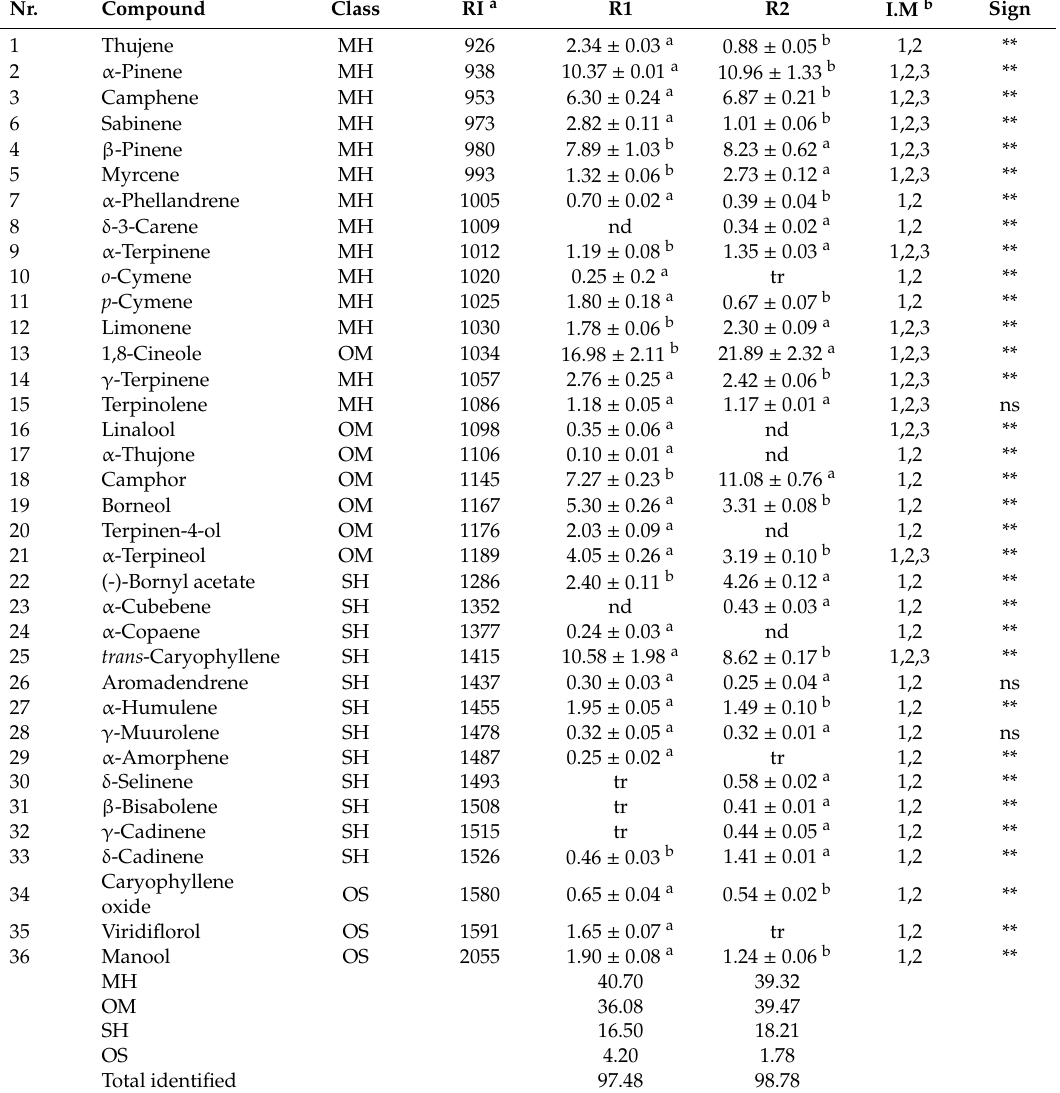
Table 1. The main constituents (%) of Salvia rosmarinus essential